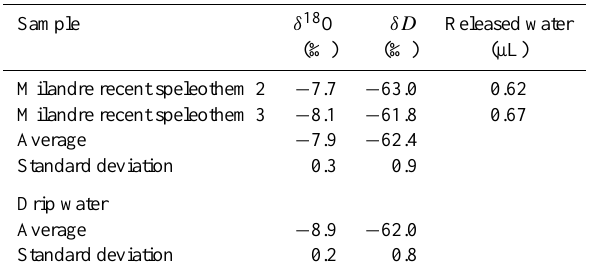
Table 5. Isotopic results for two replicates of a recent sample from Milandre cave (Switzerland) and for the corresponding drip water. δD values of speleothem and the modern drip water are coherent and really close, whereas δ 18 O seems to be slightly